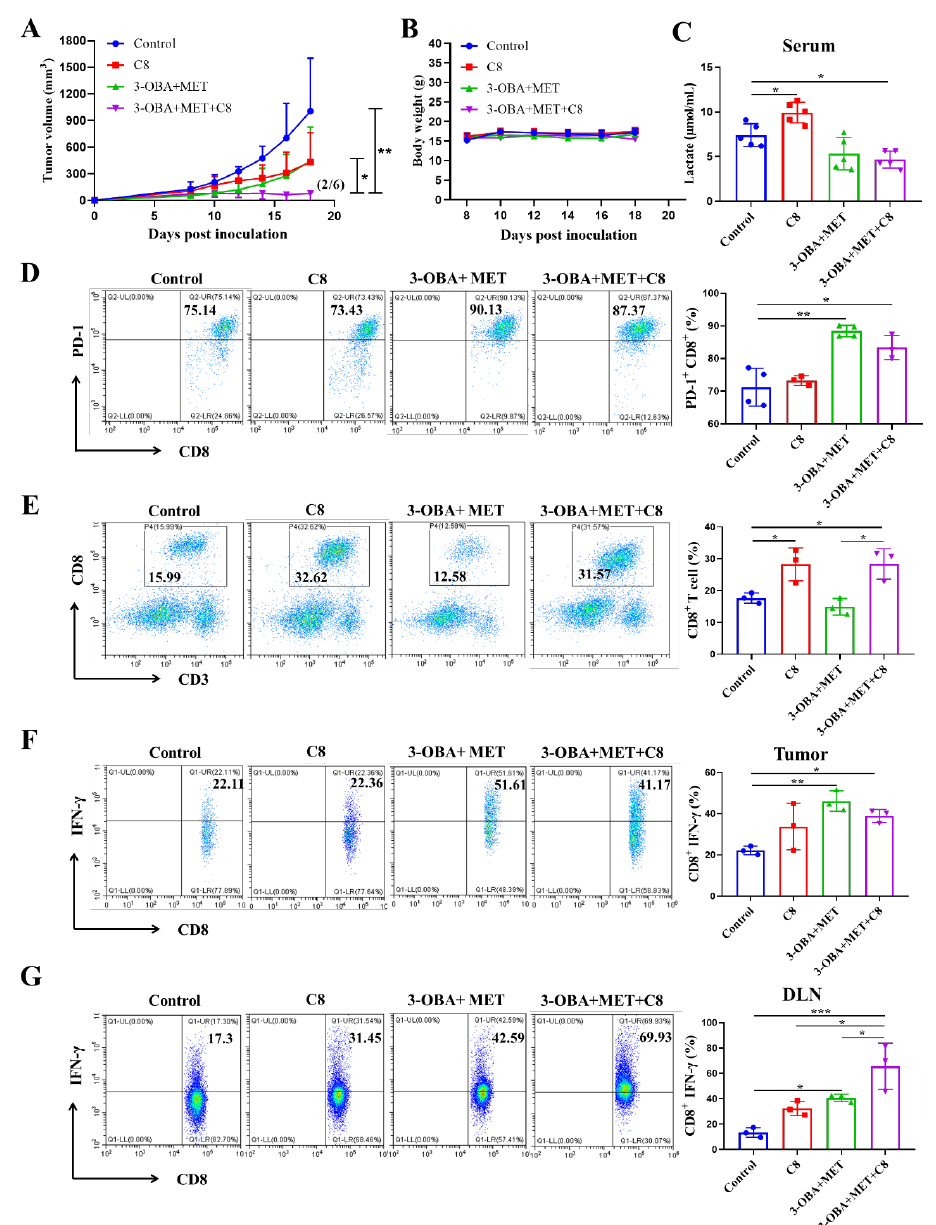
Figure 6. C8 could enhance the anti-tumor effects of the combination of 3-OBA and metformin in vivo. ( A ) Tumor volumes after different treatments. In the combination treatment of 75 mg/kg 3-OBA, 200 mg/kg metformin, and 2 mg/kg C8, tumors of two mice regressed ( n = 6). ( B ) Body weights. ( C ) Serum lactate in mice. The effects of the combination of 3-OBA, metformin, and C8 on ( D ) PD-1 expression of CD8 + T cells, ( E ) intra-tumoral CD8 + T cell proportions, ( F ) the ratio of IFN- γ + CD8 + T cells in tumors, ( G ) and in the draining lymph nodes. ( n = 3) * p < 0.05, ** p < 0.01, *** p <